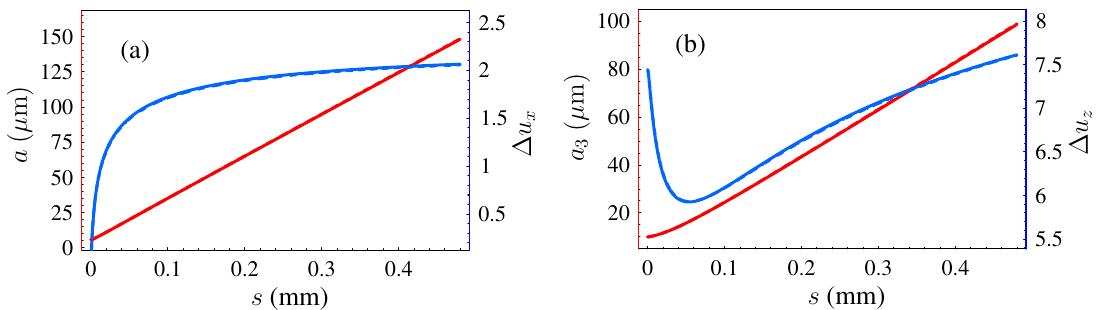
SPACE CHARGE MODELING OF DENSE ELECTRON . .